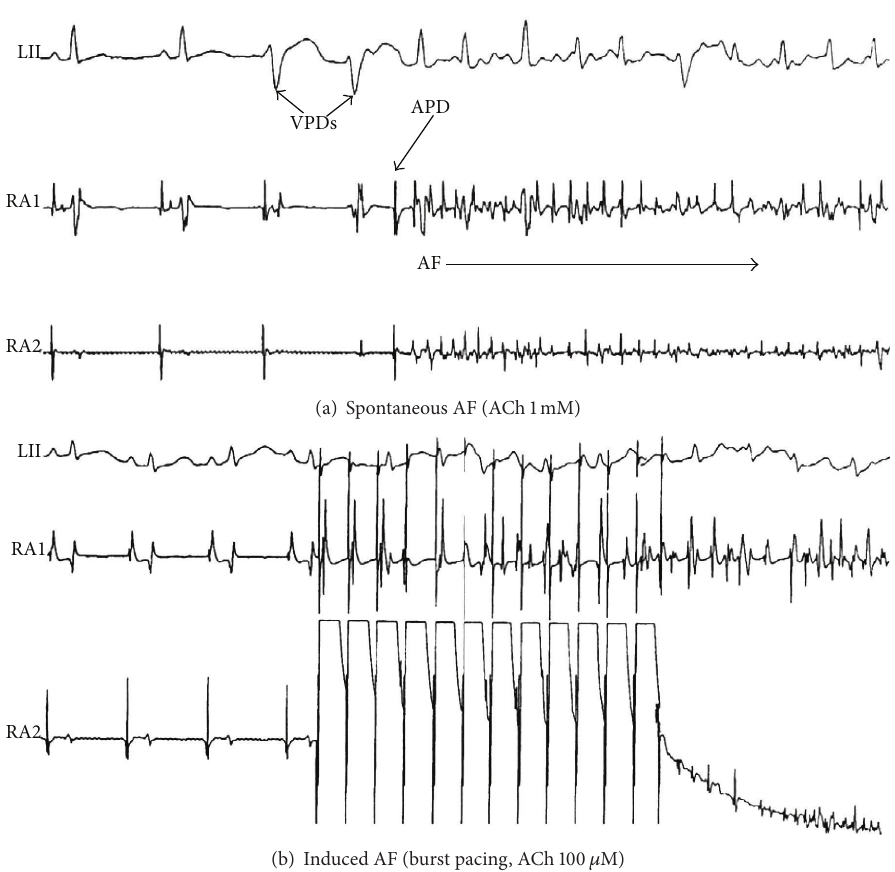
Figure 1: Examples of sustained atrial fibrillation (AF) in the old rabbits. (a) Spontaneously occurring sustained AF initiated by an atrial premature depolarization (APD) following two ventricular premature depolarizations (VPDs). (b) Burst pacing-induced sustained